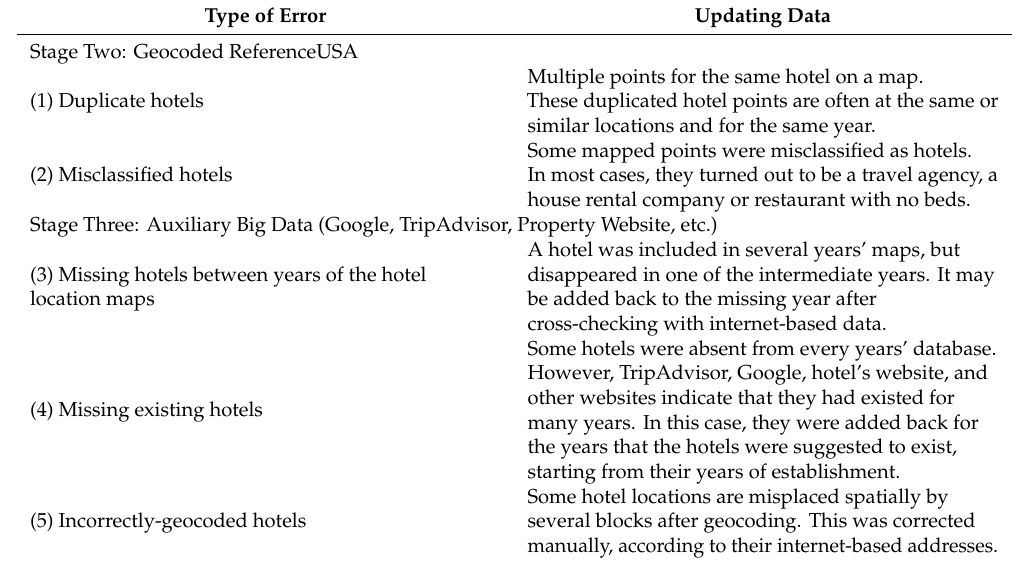
Table 1. Updating hotel data: Stage two and